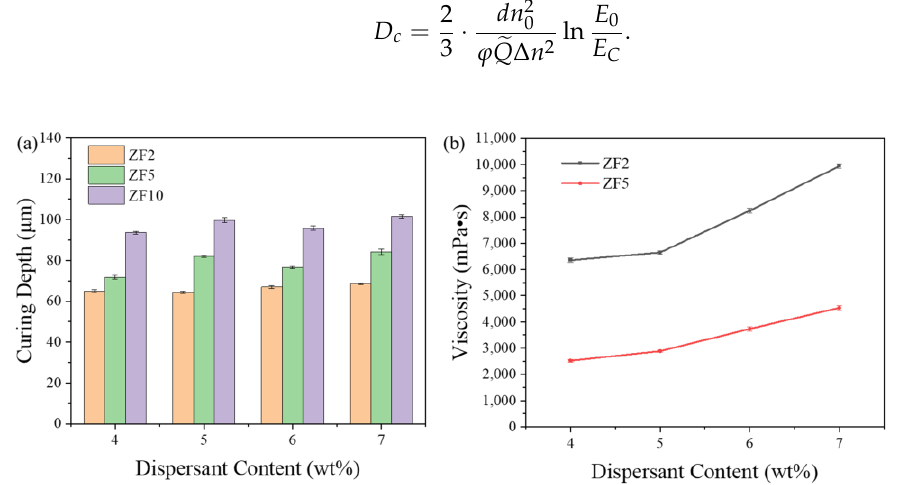
Figure 8. ( a ) Effects of the dispersant content on curing depth and ( b ) the relationships between the viscosity and dispersant content at printing conditions.